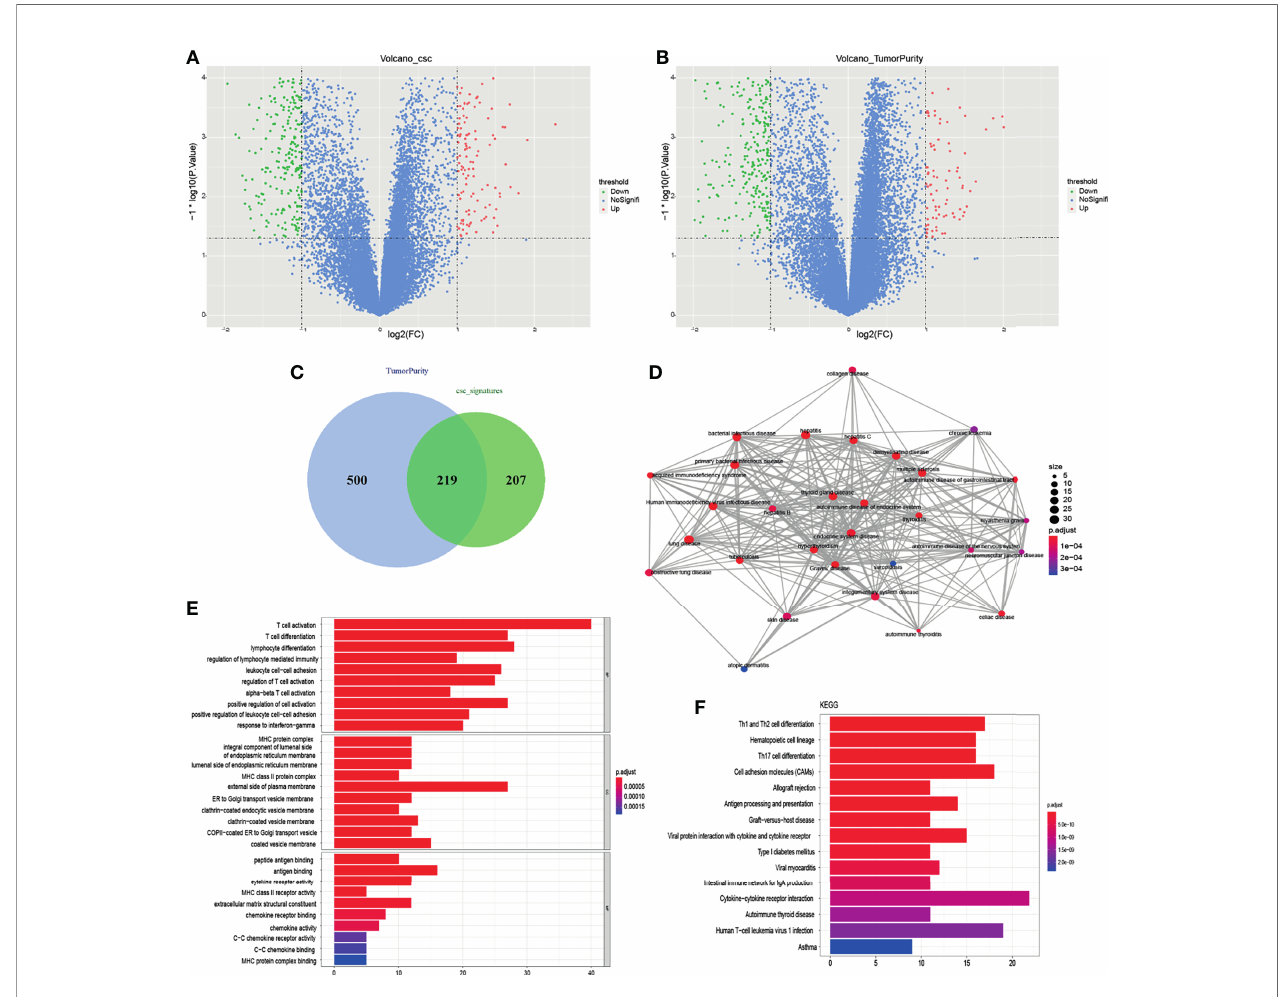
FIGURE 4 | Analysis of gene differences by combining cancer stemness index with tumor purity. (A) Gene volcano map of cancer stemness index difference. (B) Gene volcano map of tumor purity difference. (C) Two hundred nineteen differentially expressed genes were identi fi ed by the analysis of cancer stem-like properties and purity. (D) According to GO analysis, 219 gene diseases were enriched to obtain diseases signi fi cantly related to different genes. (E, F) GO analysis and KEGG analysis,